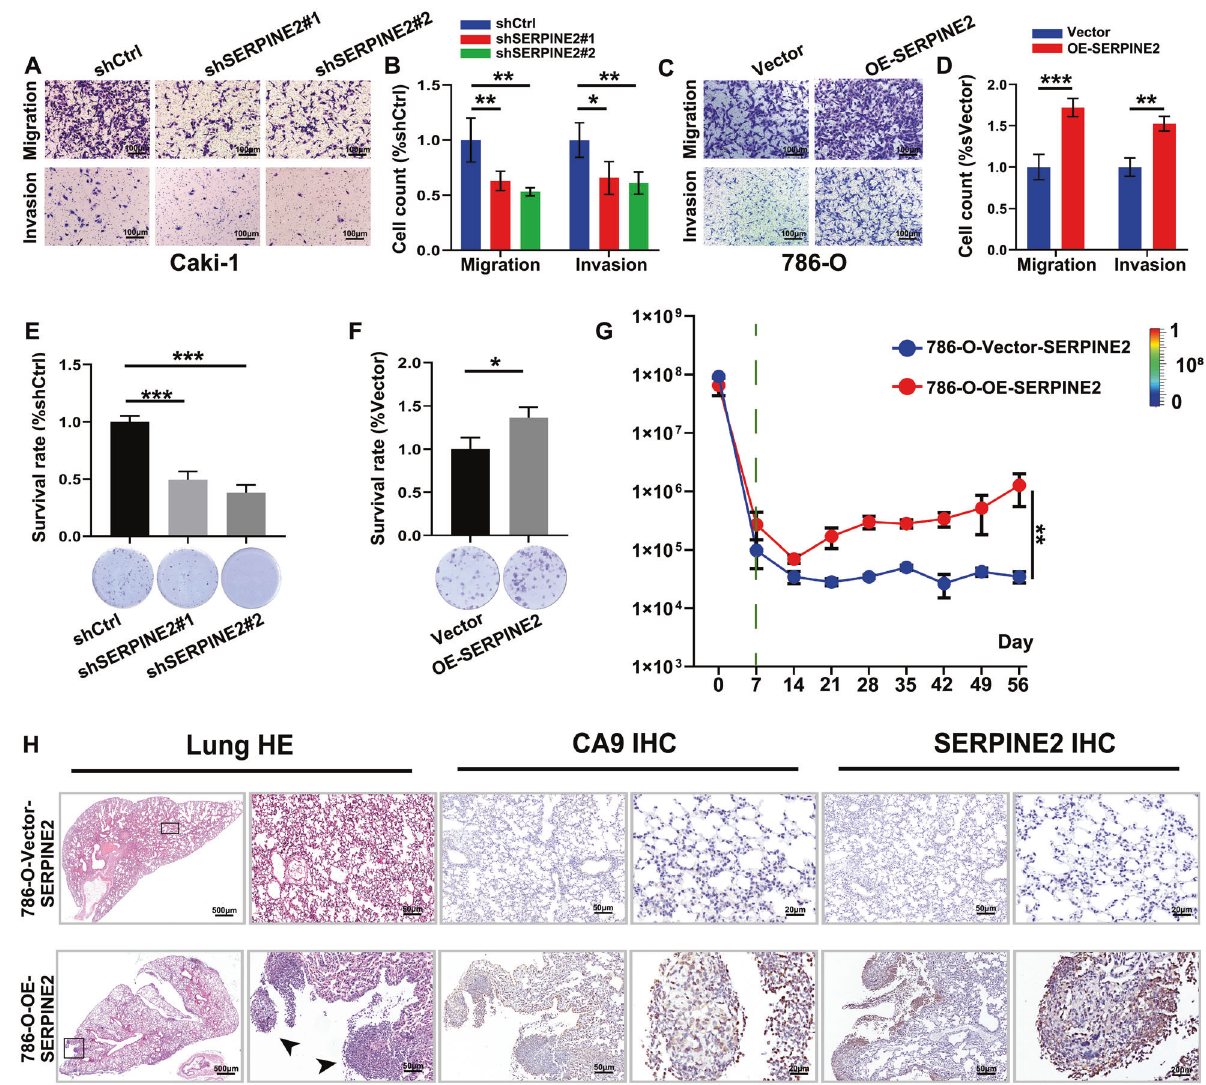
Fig. 5 SERPINE2 promotes ccRCC progression, accompanied by EMT. A , B Representative images of transwell assay without or with Matrigel shows the migration and invasion abilities among shCtrl, shSERPINE2#1 and shSERPINE2#2 group in Caki-1 cells, relative change compared with shCtrl group. Scale bar = 100 μ m. C , D Representative images of transwell assay without or with Matrigel shows the migration and invasion abilities between Vector, OE-SERPINE2 group in 786-O cell, relative change compared with Vector group. Scale bar = 100 μ m. E The cell survival rate among shCtrl, shSERPINE2#1 and shSERPINE2#2 group in Caki-1 cells, relative change compared with shCtrl group. F The cell survival rate among Vector, OE-SERPINE2 group in 786-O cell, relative change compared with Vector group. G Whole body bioluminescence (photons/second) following tail vein injection of cells in mice. Differences occurred from day 7 time point (Green line). H The lung tissue of 786-O-OE-SERPINE2 or 786-O-NC-SERPINE2 of mice; the representative lung metastasis site by HE staining. Scale bar = 500 μ m; Scale bar = 50 μ m. The IHC results of CA9 and SERPINE2; Scale bar = 50 μ m; Scale bar = 20 μ m. EMT epithelial-mesenchymal